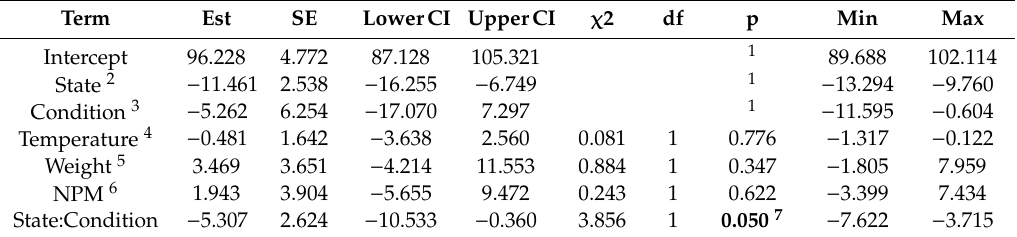
Table 2. Results of the heart rate (HR) model (estimates, standard errors, and confidence intervals (CIs)), results of the likelihood ratio tests ( χ 2, df, and p), and the estimates obtained for model stability (min and